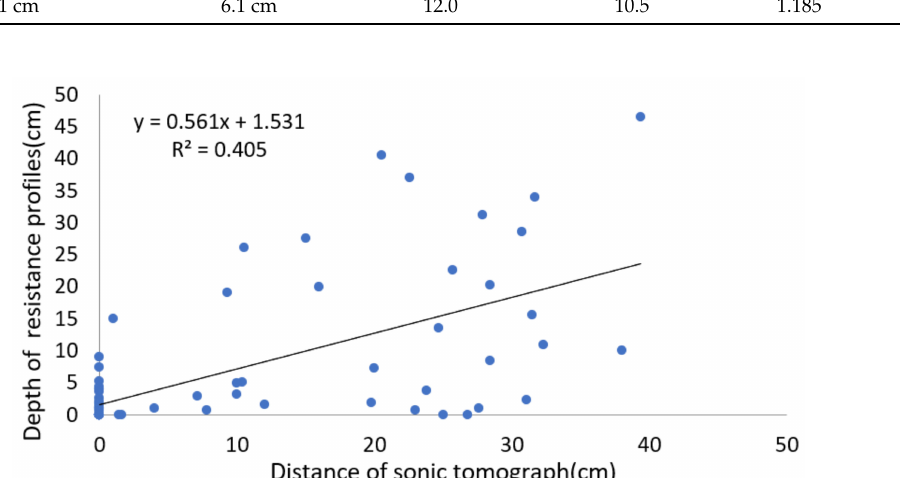
Figure 2. Predicted distance of wood with defects using sonic tomography (SoT) versus the distance of defects using electric resistance tomography (ERT). Trend line = linear regression ( p < 0.001, n =